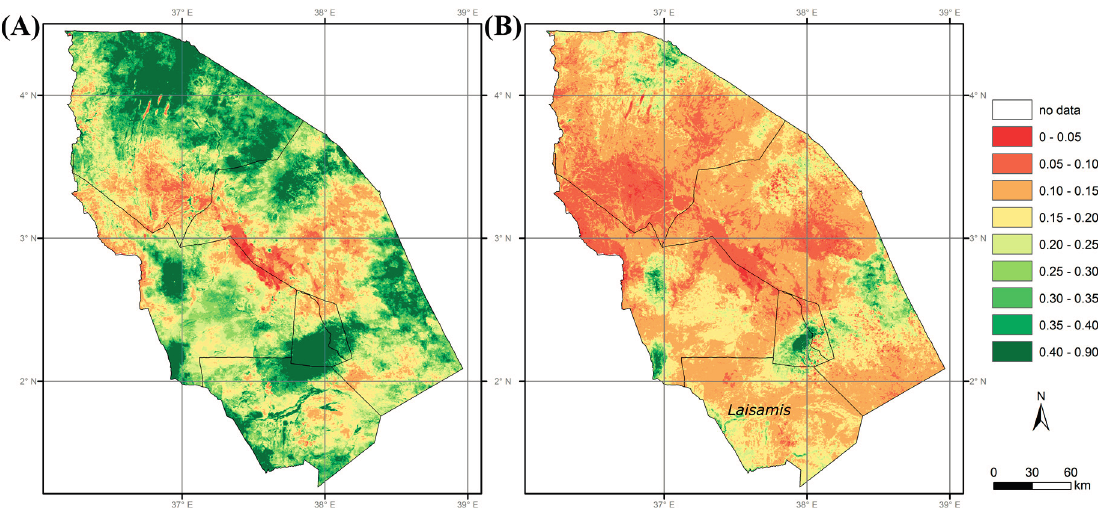
Figure 3. MODIS NDVI during the first decade of May during a good (2010, A ) and a poor long rainy season (2011, B ) in Marsabit District (now Marsabit County). The black lines show the boundaries of the six divisions that are contained in Marsabit District. The southern division Laisamis corresponds to Figure